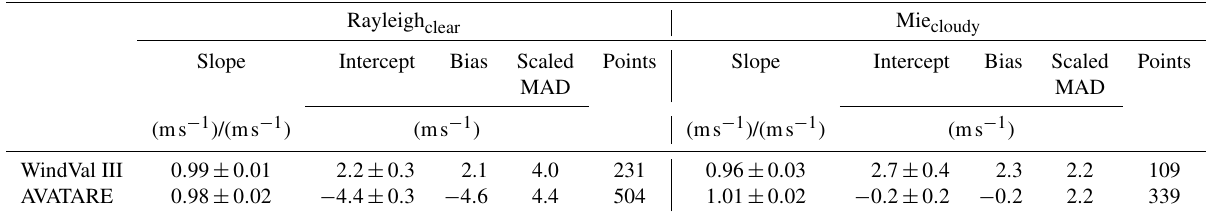
Table 3. Comparison of Aeolus HLOS winds and 2µm DWL winds projected onto the horizontal viewing direction of Aeolus. Rayleigh clear Mie cloudy Slope Intercept Bias Scaled Points Slope Intercept Bias Scaled Points MAD MAD